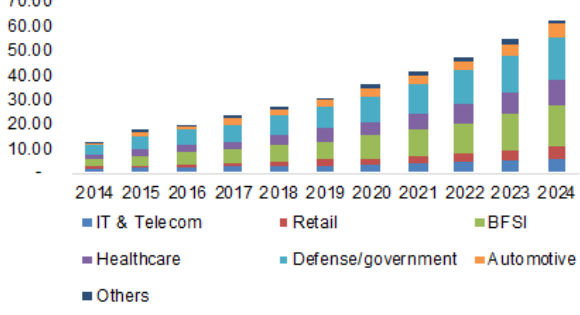
Figure 1. Global Cyber Security Market Size (Source: Grand View Research,